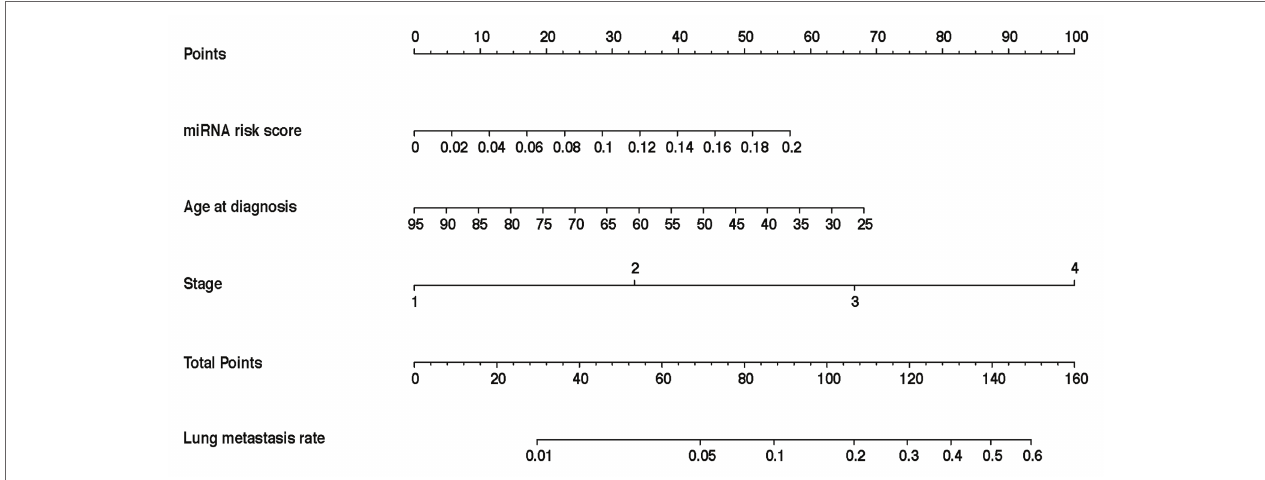
FIGURE 3 | Development and assessment of the miRNA-based nomogram. Constructed a miRNA-based nomogram to predict LM for BC patients in the training cohort, with age at diagnosis, stage, and eight-miRNA signature incorporated. LM, lung metastasis; BC, breast cancer; and miRNA, micro